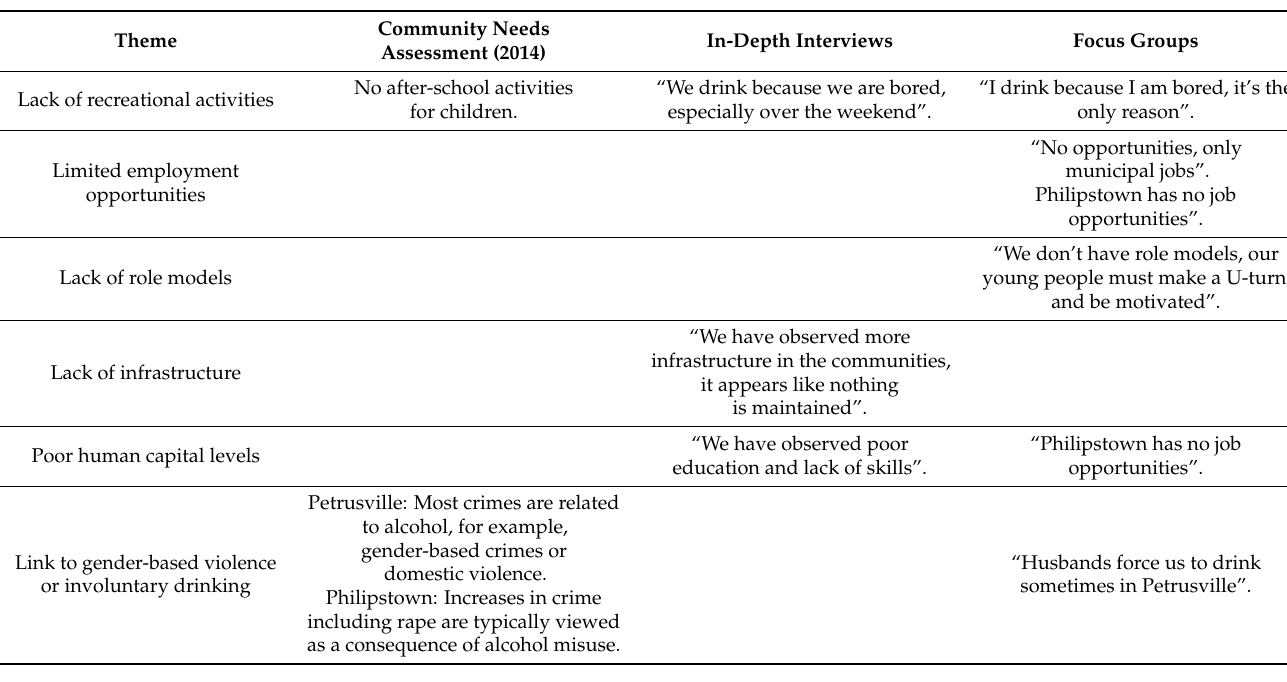
Table 9. Drinking motives in RLM.